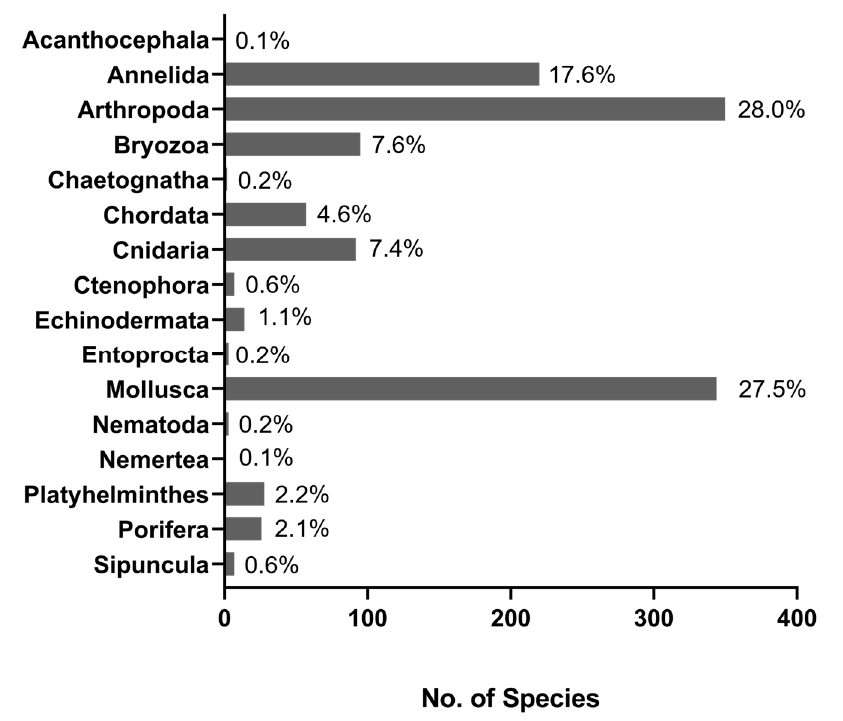
Figure 2. Taxonomic composition of the 1249 invertebrate marine non-indigenous species compiled from the three databases: EASIN, AquaNIS, and WRiMS. Chordata only includes Ascidiacea.